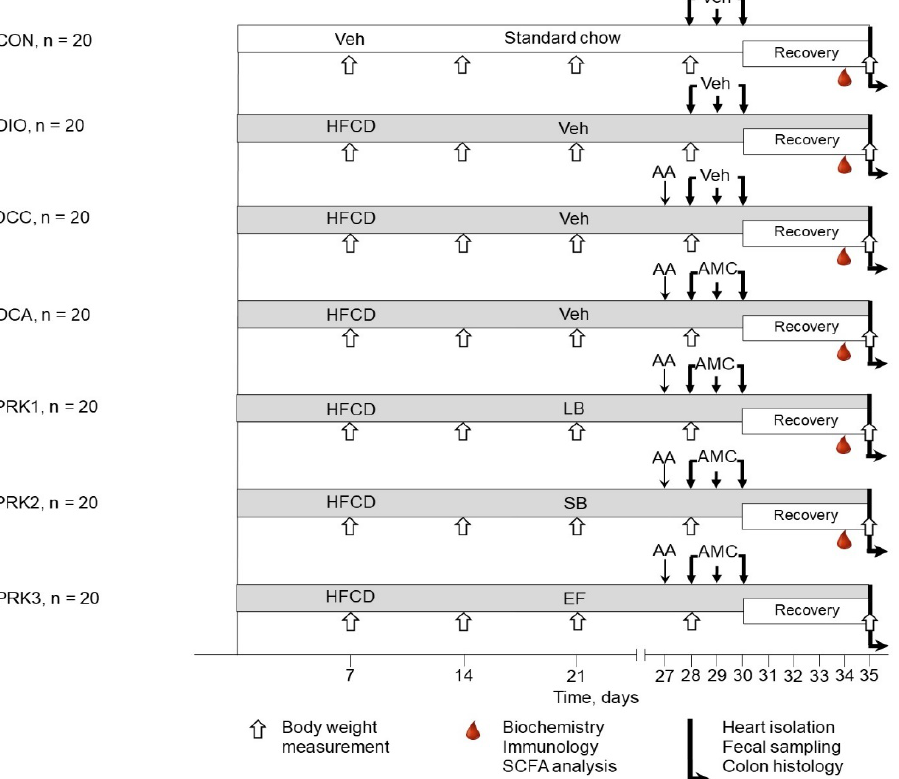
Figure 1. Experimental protocol. For details, see text. AA—acetic acid; AMC—antimicrobial compounds; EF— Enterococcus faecium L3 ; HFCD—high-fat, high-carbohydrate diet; LB— Lactobacillus acidophilus (LA–5) and Bifidobacterium animalis subsp. lactis (BB–12) ; SCFA—short-chain fatty acids; SB— Saccharomyces boulardii ;